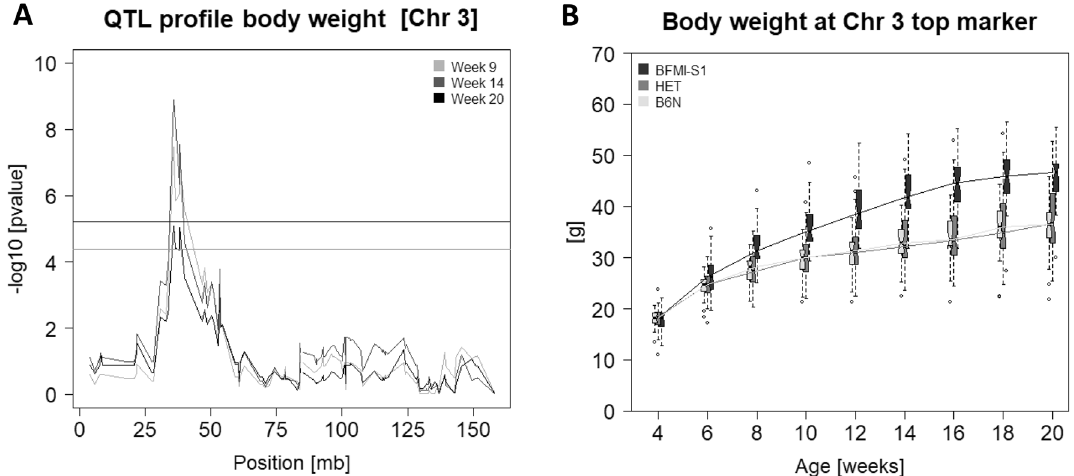
Figure 2. ( A ) QTL mapping curve of the jObes1 locus on chromosome 3 for total body weight at week 9, 14, and 20. The black (1%) and grey (5%) horizontal lines mark the significance thresholds. ( B ) Boxplots for mice aged 4–20 weeks and curves depicting body weight development. For every time point, boxplots for all three genotype classes (BFMI-S1, BFMI861-S1 homozygous; HET, heterozygous; B6N, C57BL/6 N homozygous) are shown at SNP gUNC5036315, which is located at the top position of the jObes1